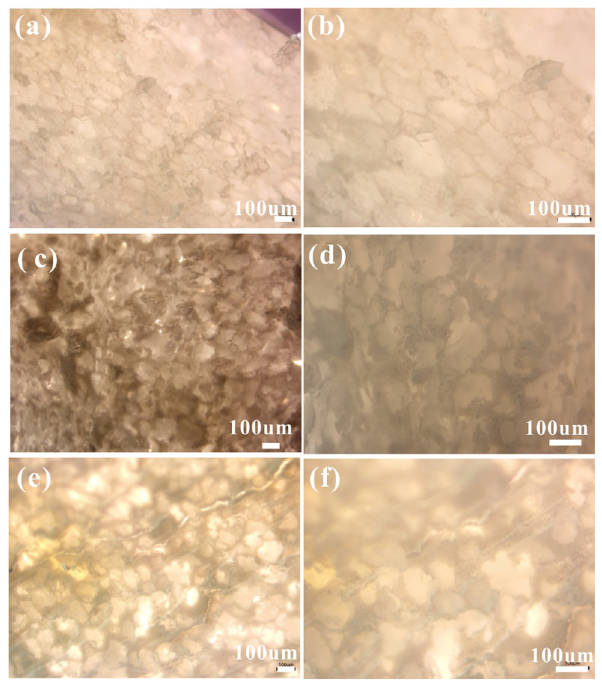
Figure A2: Optical micrographs of BN@UHMWPE with 2.1 vol% ( a and b ) , 21.6 vol% ( c and d ) , and 38.3 vol% ( e and f ) of